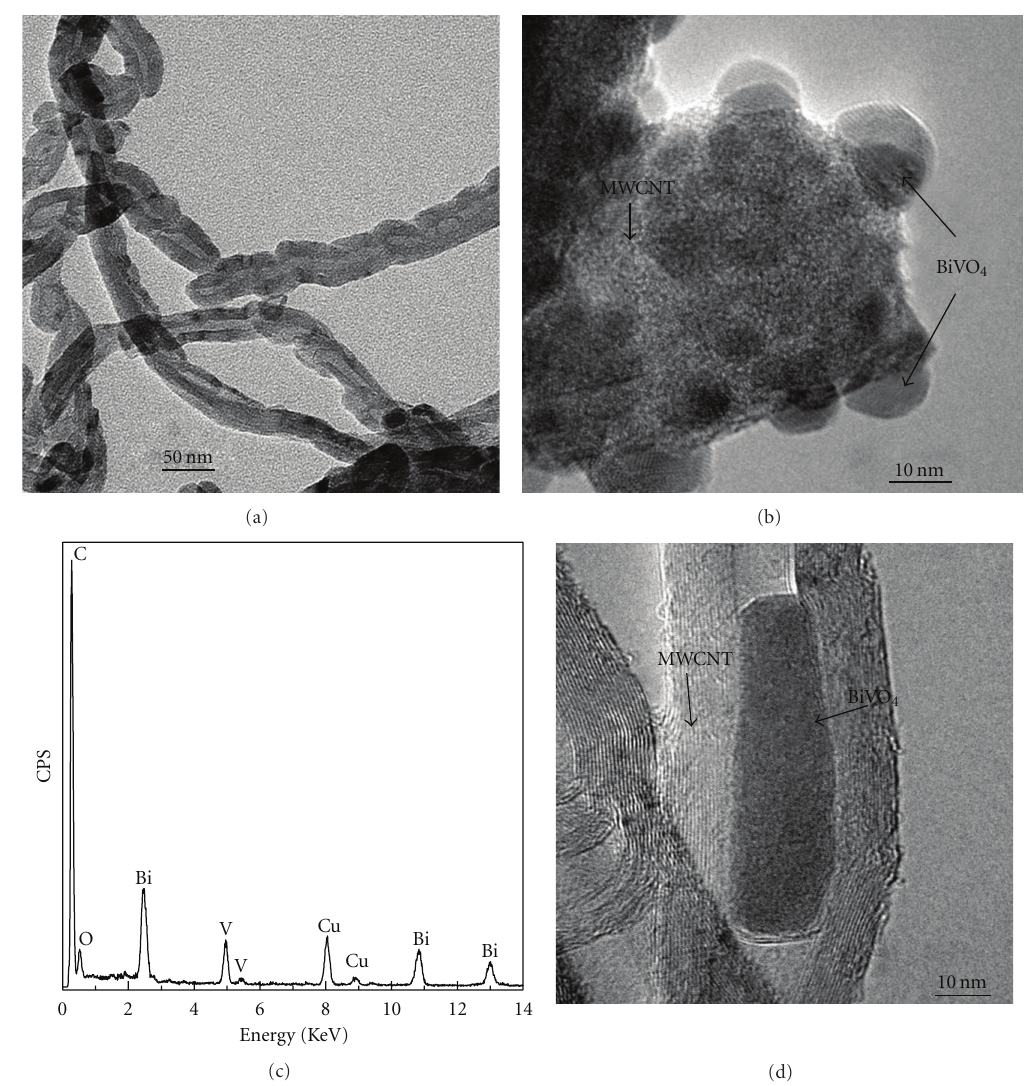
Figure 4: TEM images of (a) pure MWCNTs, (b, d) BiVO 4 @MWCNTs, and (c) EDX spectrum of BiVO 4